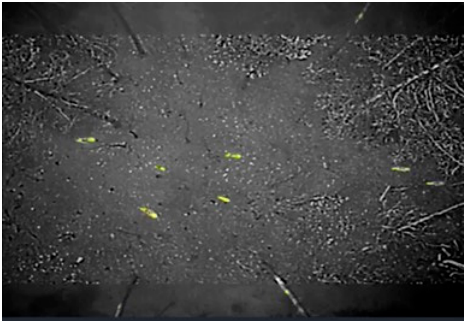
Figure 9. Wild boar silhouette taken at 1x magnification from an altitude of 40 m.